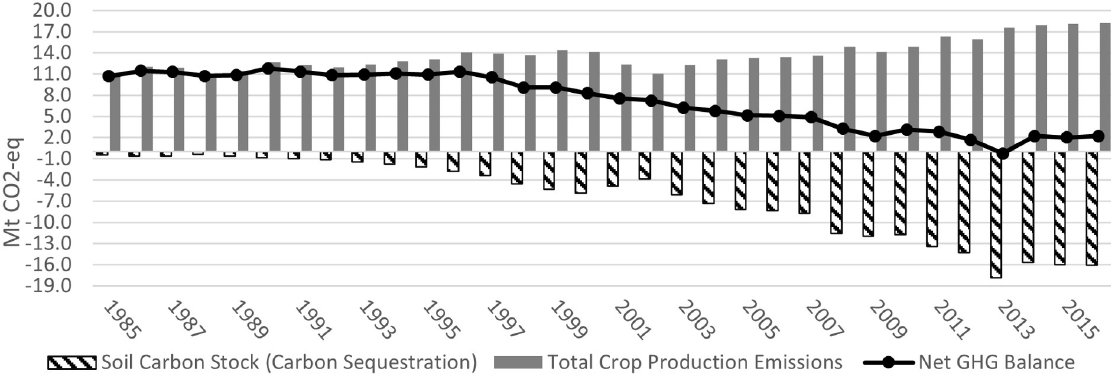
Fig 6. Canadian Prairies GHGs estimates in the crop sector (Mt CO2-eq) (1985–2016).